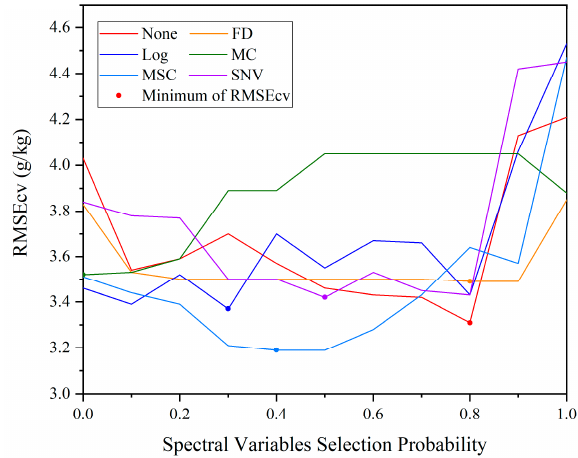
Figure 7. Five-fold root mean square error of cross-validation (RMSE cv ) for di ff erent spectral variable selection probability by Random Frog (RF) shown for di ff erent spectral pretreatments.